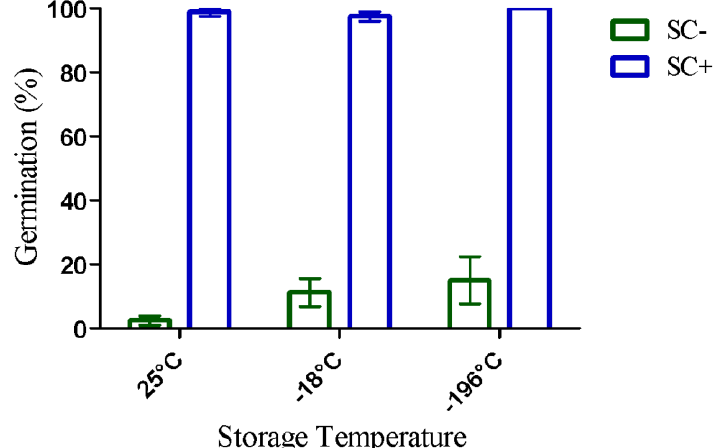
Figure 3. Germination percentages of Ipomoea cynanchifolia Meisn. seeds with (SC+) and without scarification (SC − ), stored at three different temperatures: 25, − 18, and − 196 °C for seven days.